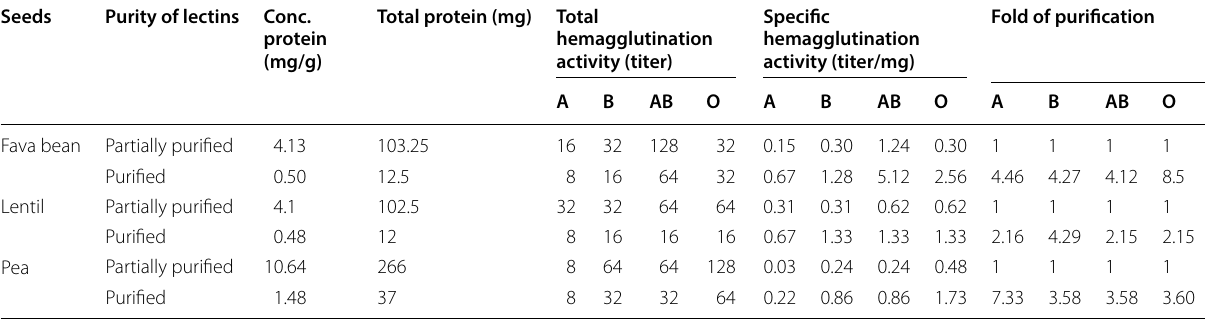
Titer, the reciprocal of the heights dilution of protein solution showing visible hemagglutination